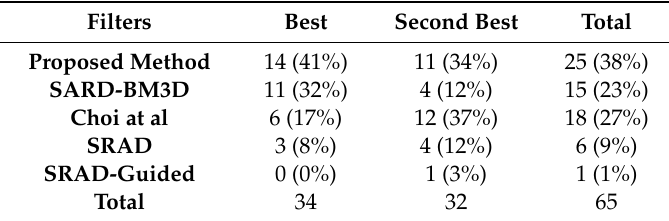
Table 6. The number of best, second best, and the sum of both.